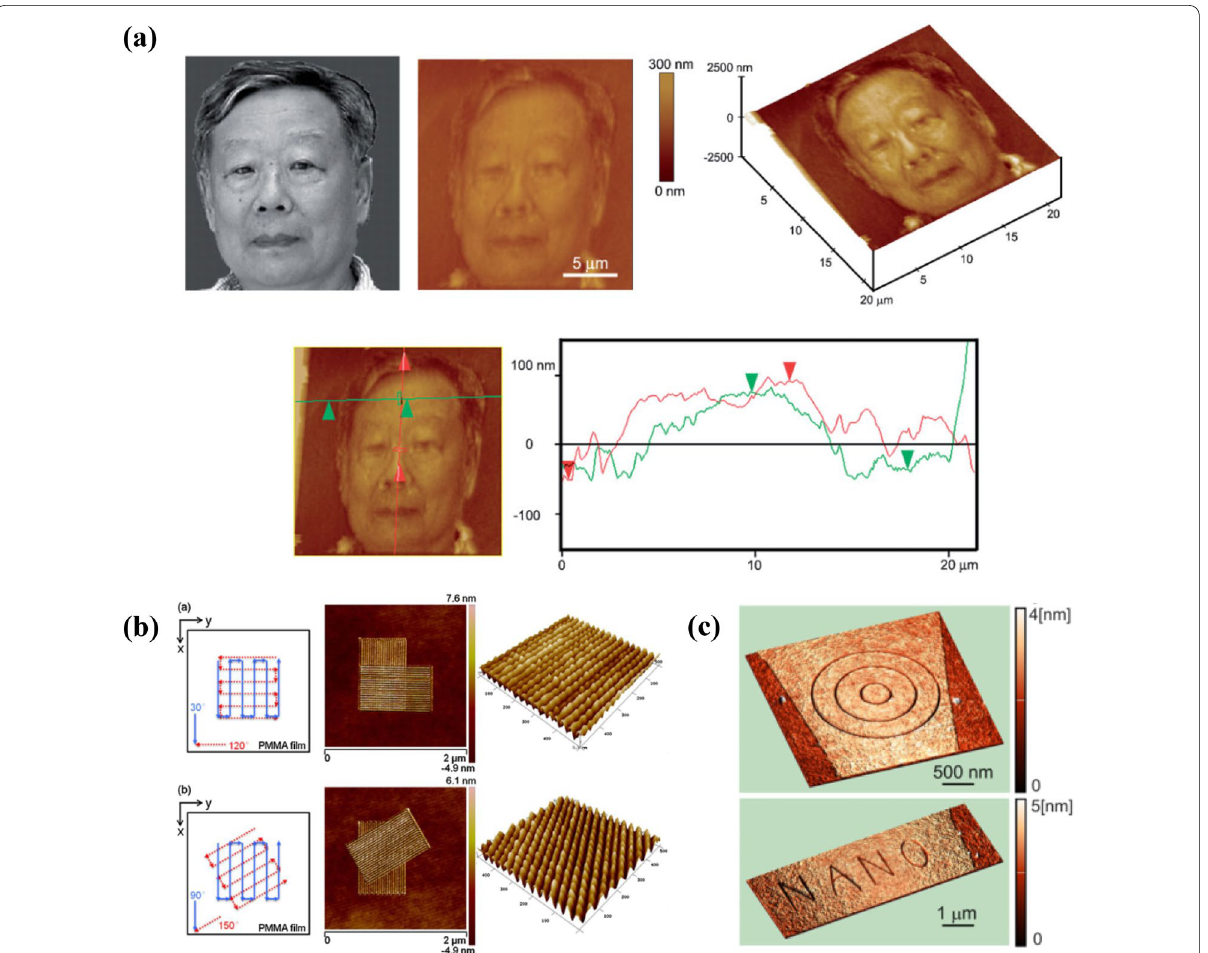
Figure 2 Nanopatterning on material surfaces through mechanical removal by scanning probe: ( a ) Fabrication of human face nanostructure on Al surface under contact mode [28], ( b )–( c ) Fabrication of nanostructures on PMMA (Figure 2b) and graphene film ( c ) using dynamic plowing lithography based on AFM [31,